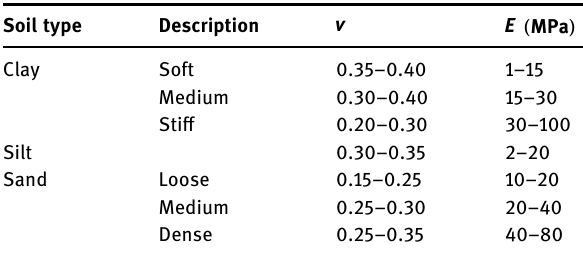
Table 1: Experimental correlation between soil type and elastic parameters